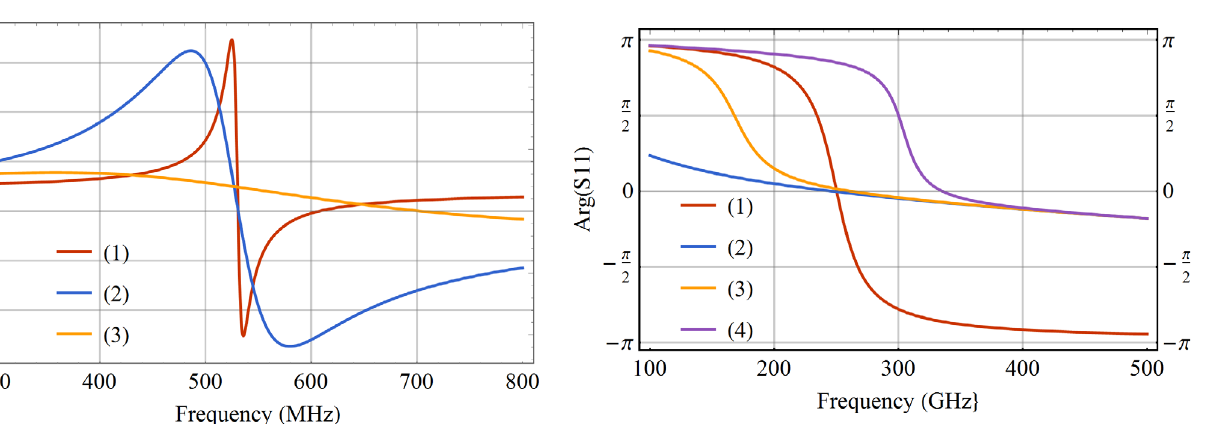
Fig. 3. Effective permeability (real part) of a SRR array vs frequency: (1) L neg =0, C p =2pF, R NF =0 V (2) L neg = (cid:2) 40 nH, C p =18 pF, R NF =0 V (3) L neg = (cid:2) 40nH, C p =18 pF, R NF =17 V .